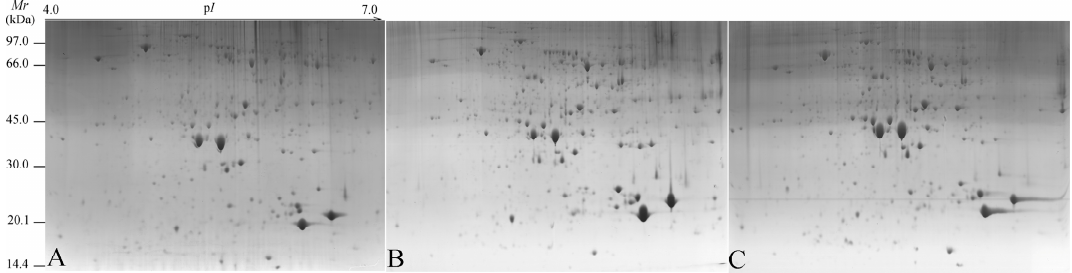
Figure 3. Images from the 2-DE gel maps of tung oilseeds from the three developmental stages tung tree seeds collected at three time-points: 25 August ( A ); 9 September ( B ); and 26 September ( C ).